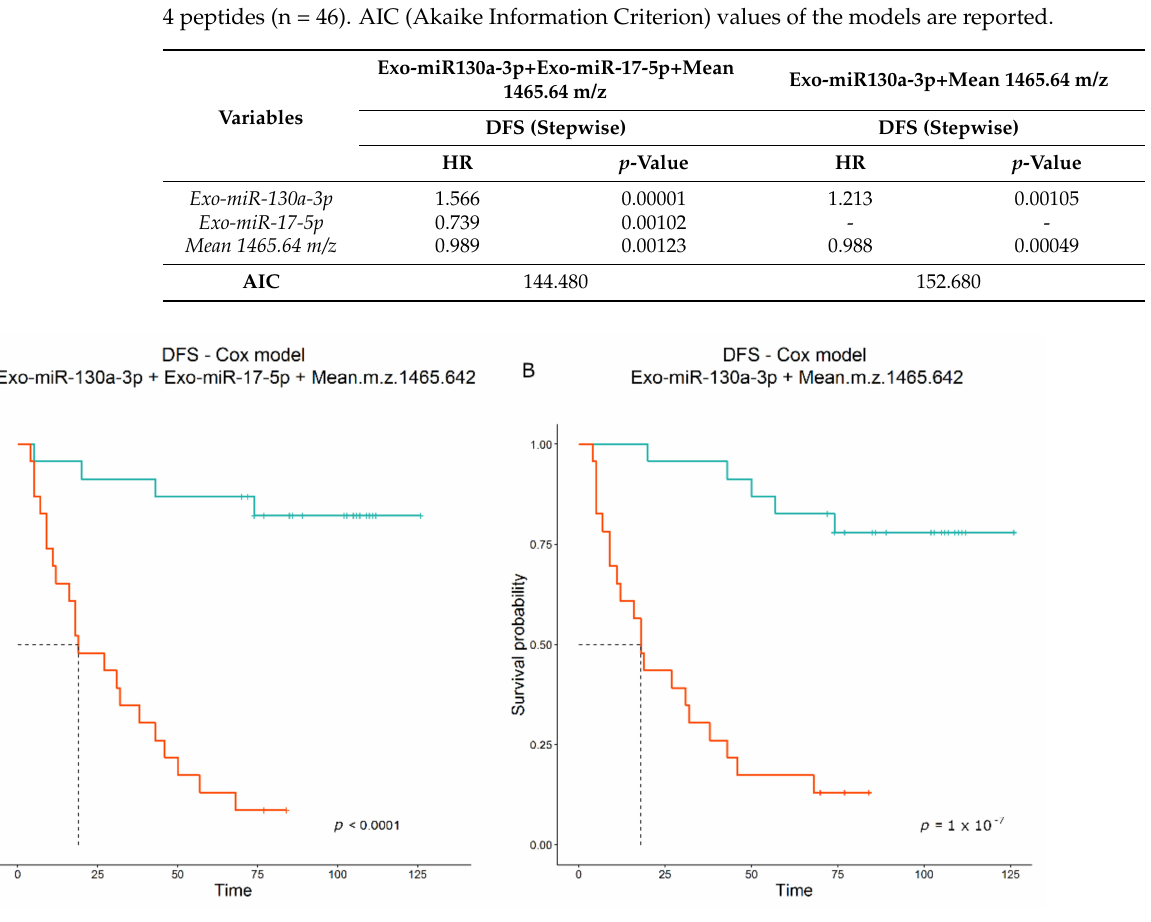
Figure 5. ( A ) Kaplan–Meier curves obtained by stratifying 46 patients according to the model score that combines Exo-miR-130a-3p, Exo-miR-17-5p (ddPCR data) with 1465 m/z (FpA(2–16)). Median DFS is 19 months. ( B ) Kaplan–Meier curves obtained by stratifying 46 patients according to the model score that combines Exo-miR-130a-3p and 1465 m/z (FpA(2–16)). Median DFS is 18